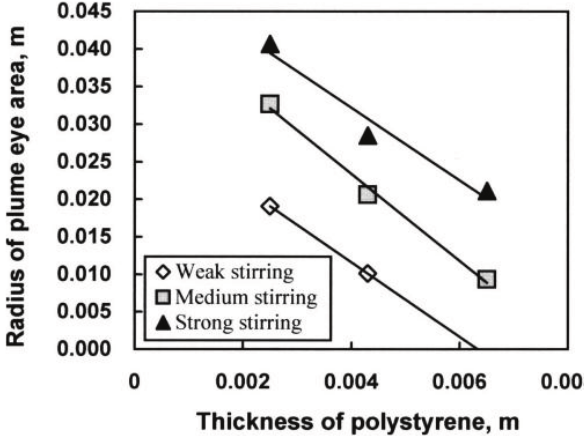
Figure 9. Influence of polystyrene thickness on plume eye area.